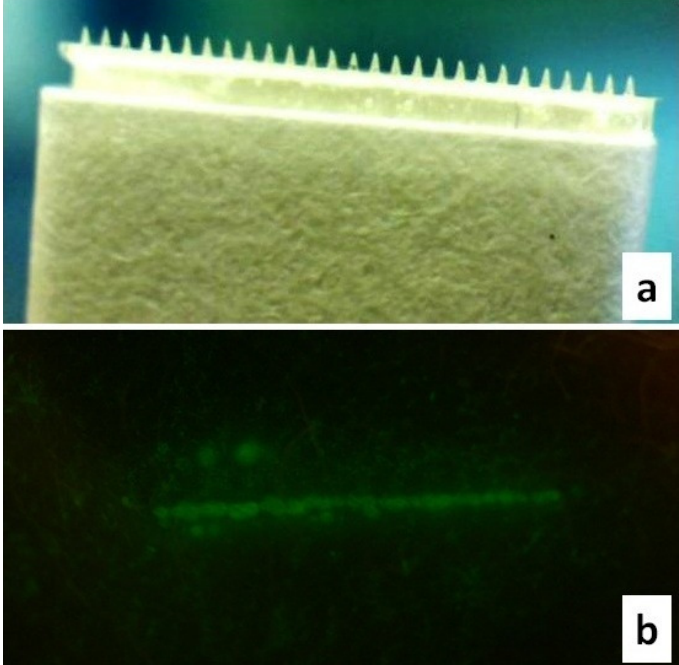
Figure 5. Maltose microneedles: (a) Video microscopic image of a single line of maltose microneedles; (b) Calcein imaging indicated successful creation of microchannels; single